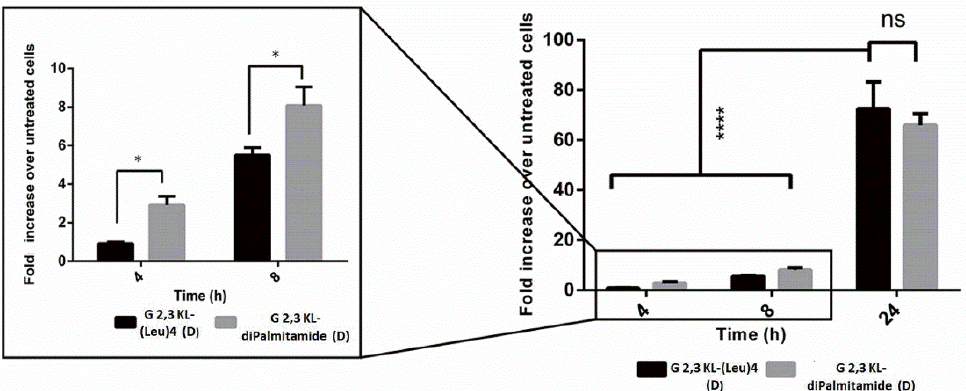
Figure 5. Luciferase activity as a measure of splice-correction levels of the lipophilic peptide dendrimers (G 2,3 KL-(Leu) 4 (D) and G 2,3 KL-diPalmitamide (D)) at different time points. Dendrimers were formulated in OptiMEM ® and HBG, respectively. Luciferase activity levels were measured after HeLa Luc/705 transfection with the dendrimers in serum-containing media. Each bar represents the mean with the SEM of at least three independent experiments performed in triplicate ( n ≥ 3). p -values were calculated by two-way ANOVA test, and the statistical difference was measured using post hoc Fisher’s LSD test. (ns: non-significant, * p ≤ 0.05, and **** p ≤ 0.0001).